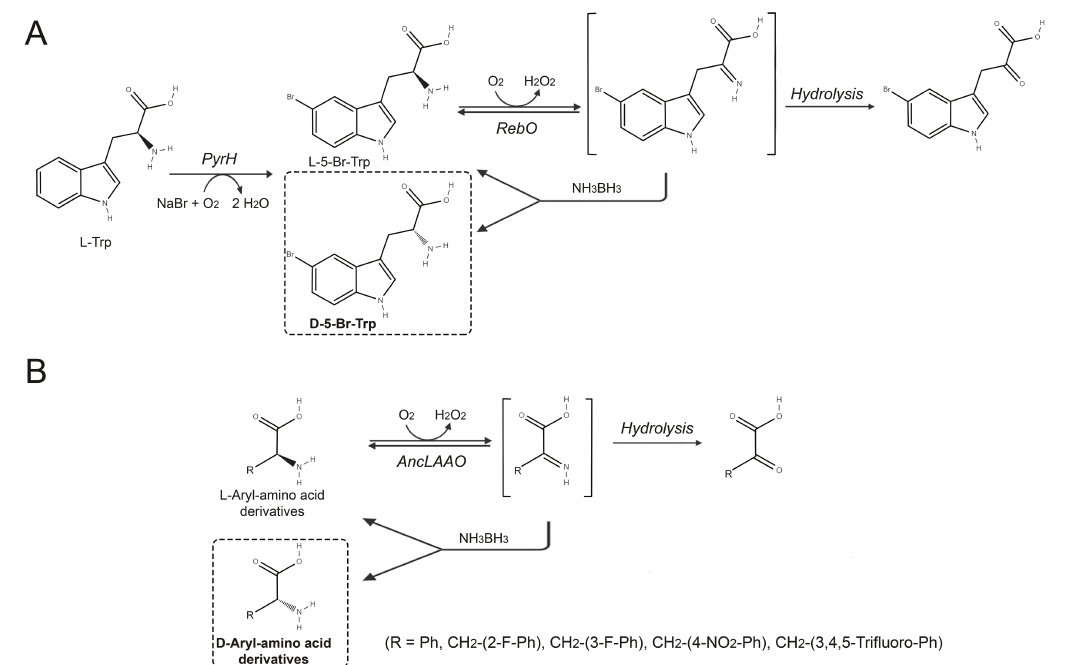
Figure 8. Production of D-AAs by L-amino acid oxidase. ( A ) Two-step biocatalytic synthesis of D-5-Br-tryptophan using a one-pot approach by combining tryptophan 5-halogenase from Streptomyces rugosporus with RebO, without intermediary purification. Iteration of enantioselective oxidation of the L-enantiomer by RebO and subsequent chemical reduction into the racemate induced accumulation of the D-AA [53]. ( B ) Application of ancestral variant of LAAO (AncLAAO) in the deracemization of substituted phenylalanines and phenylglycine